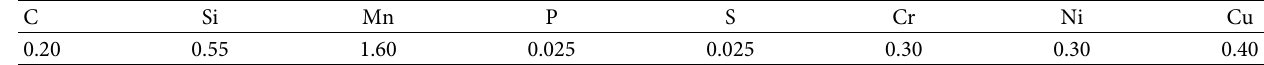
Table 1: Chemical composition of Q345qD steel (mass fraction, %).